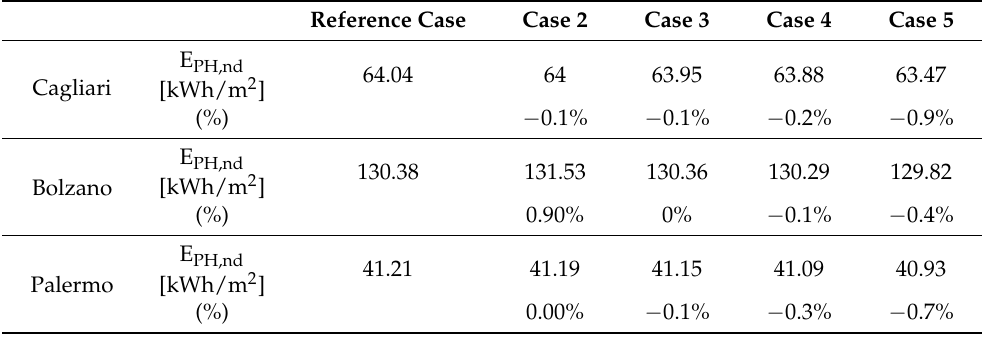
Table 7. Useful thermal energy requirements E PH,nd on walls that already meet the regulatory